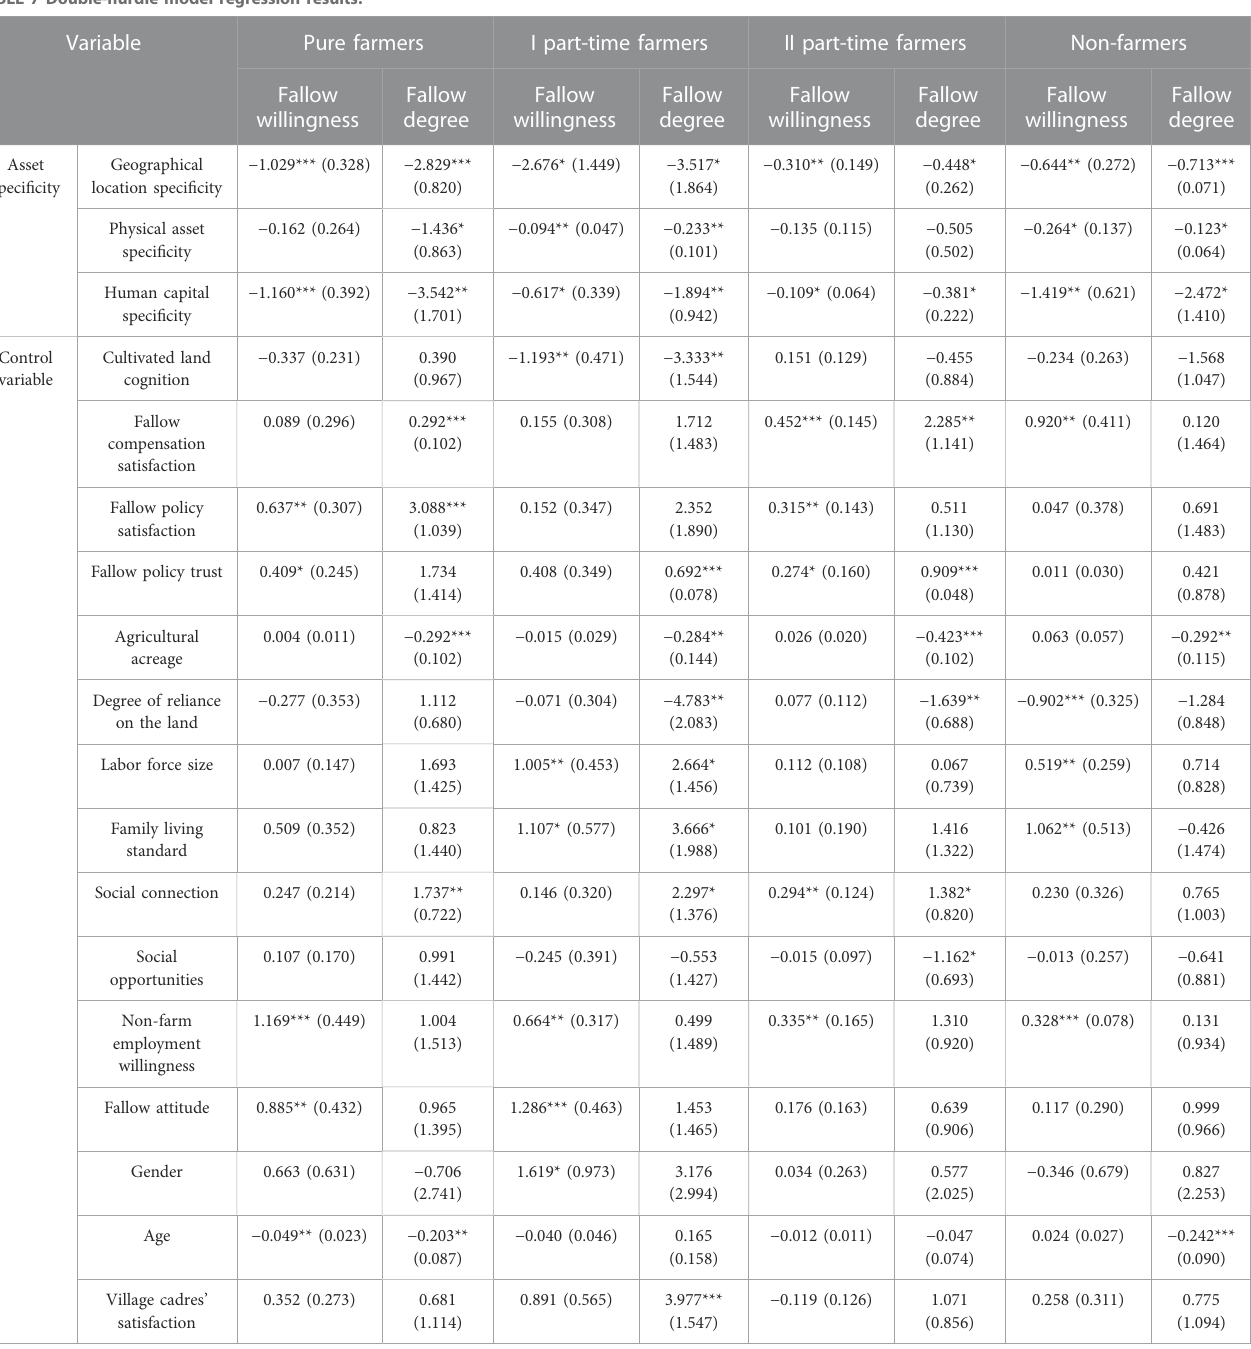
TABLE 7 Double-hurdle model regression results.